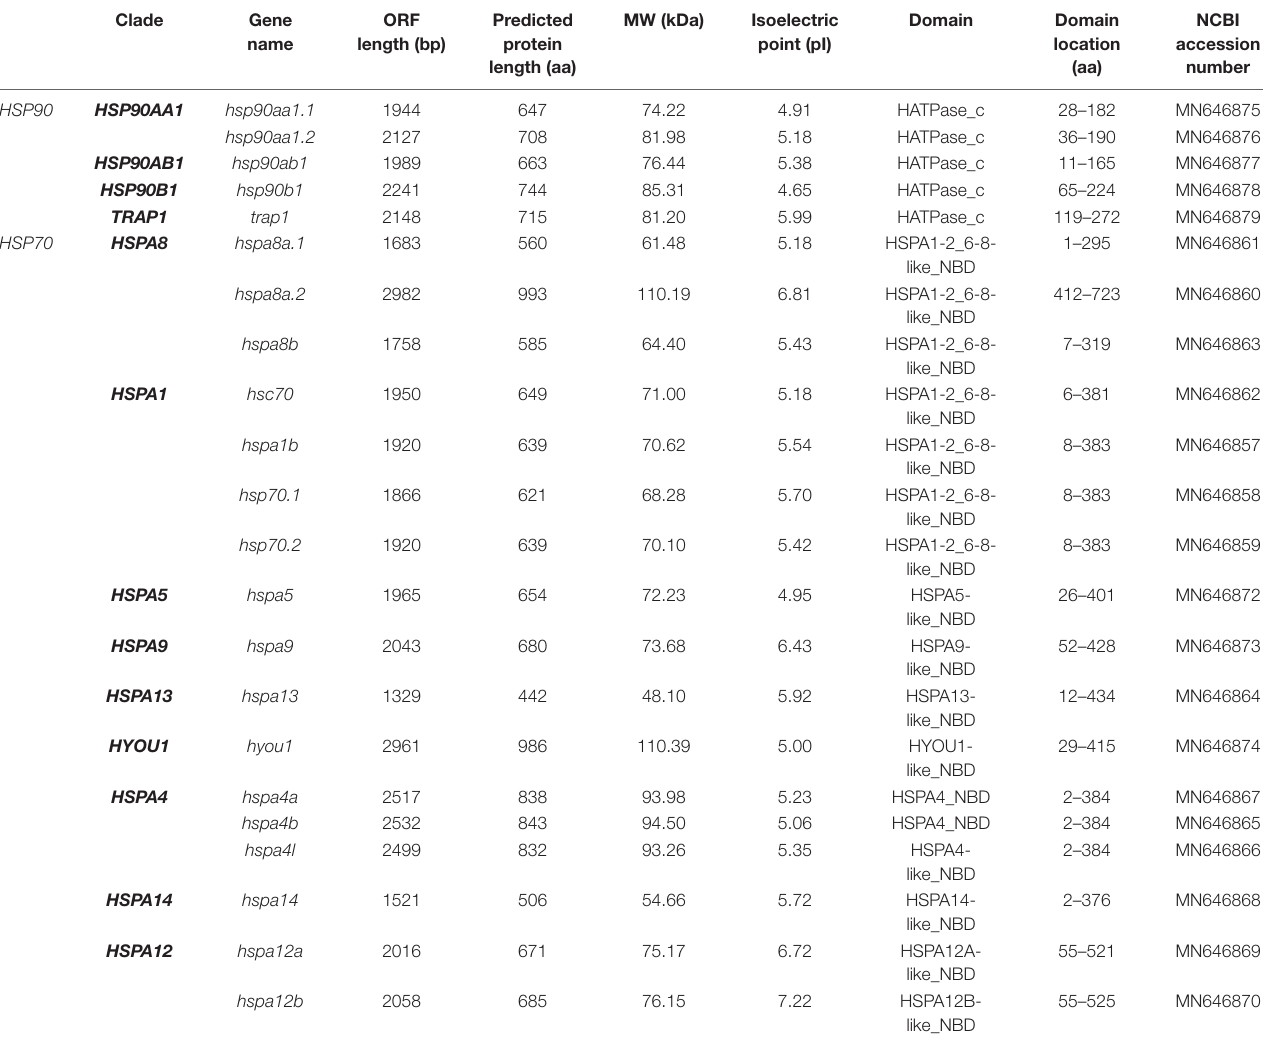
TABLE 2 | Summary of sequence characteristics of HSP90 and HSP70 genes in spotted seabass.